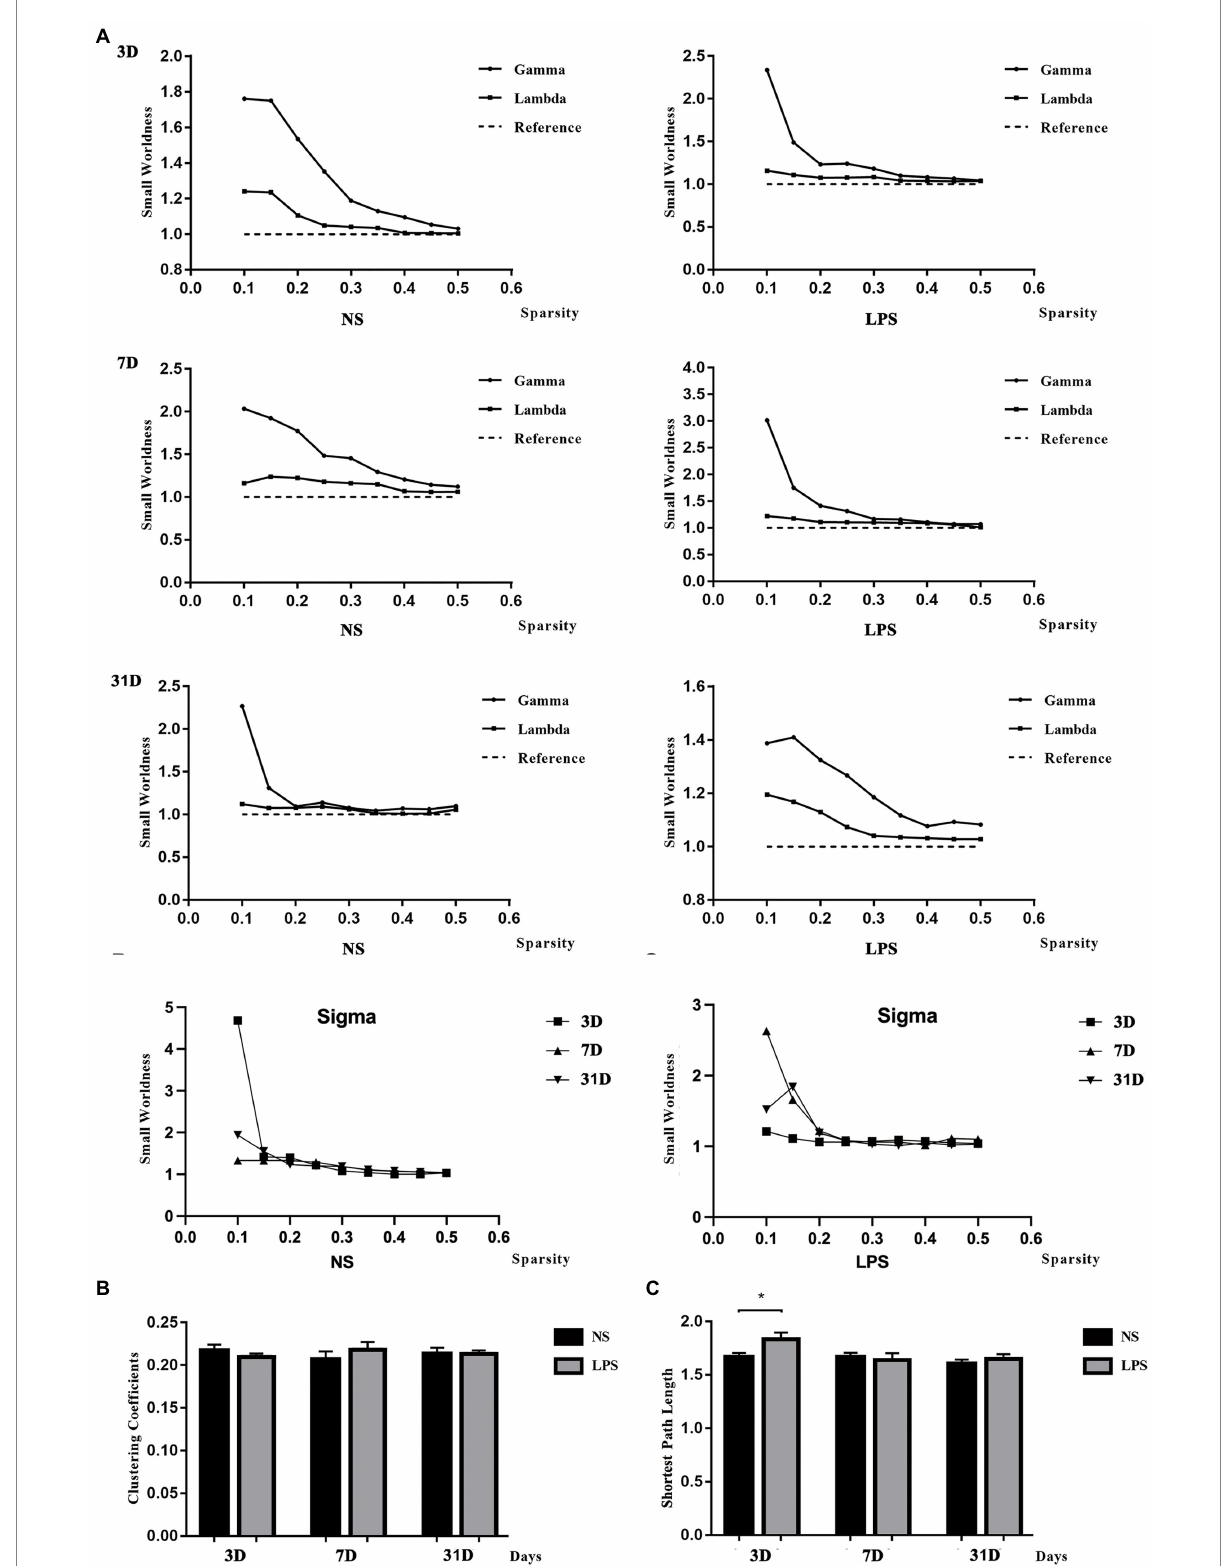
FIGURE 6 Small-worldness in aged rat default mode network (DMN). (A) The DMN in lipopolysaccharide (LPS) exposed and control rats showed the small- worldness at all time points. (B) LPS exposure caused no alteration in clustering coefficient ( C p ). (C) LPS exposure caused increased shortest path length (Lp) persisting for 3 days. Data were analyzed using two - sample t -test with false discovery rate (FDR) correction. ** p < 0.01 vs. control